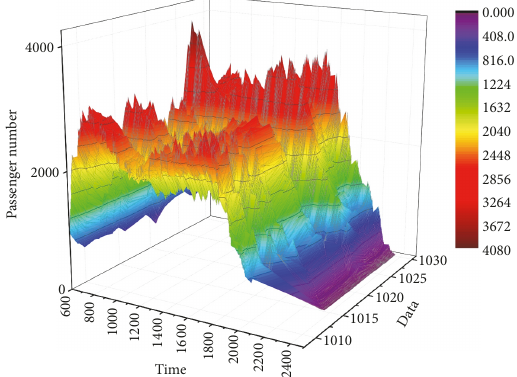
Figure 6: Passenger number variation with different time (X axis) and different date (Y axis).